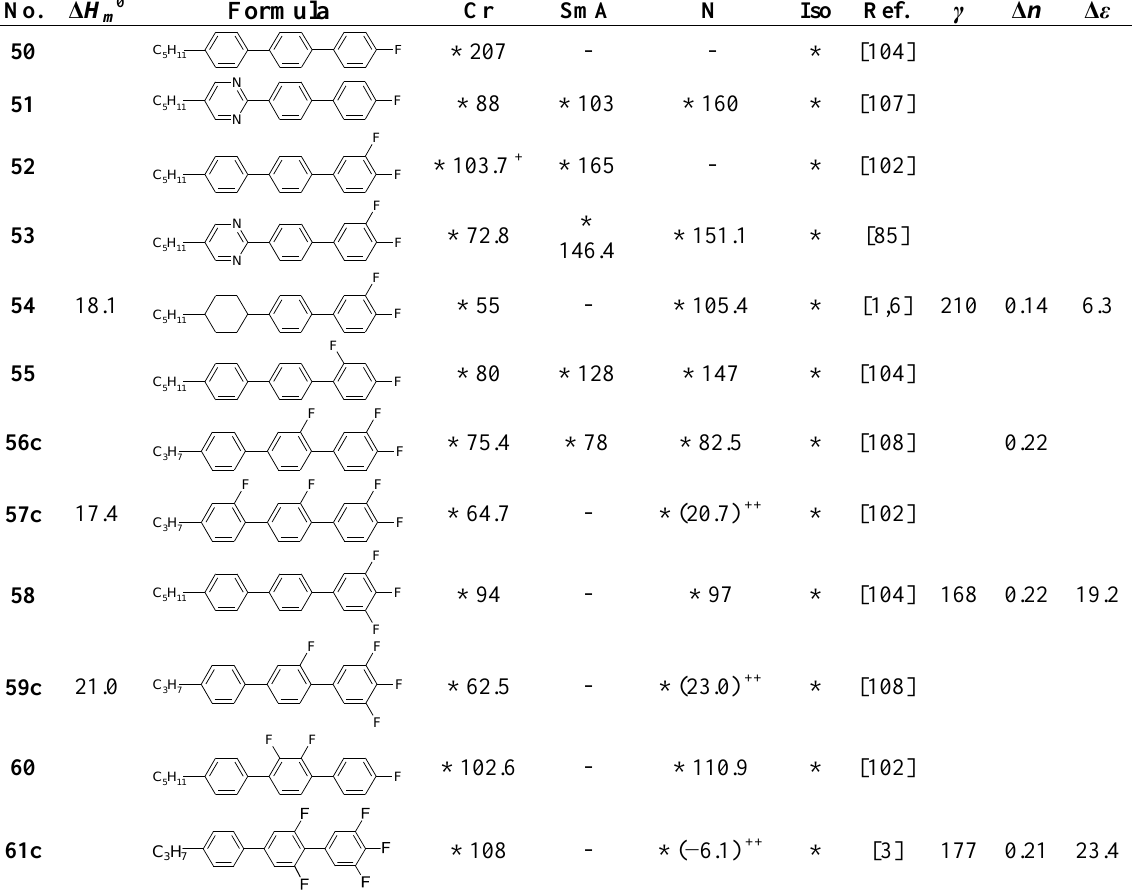
Table 9. Phase transitions temperatures [°C], enthalpies [kJ/mol], birefringence, rotational viscosity [mPa∙s] and dielectric anisotropy of alkyl fluoroterphenyls.